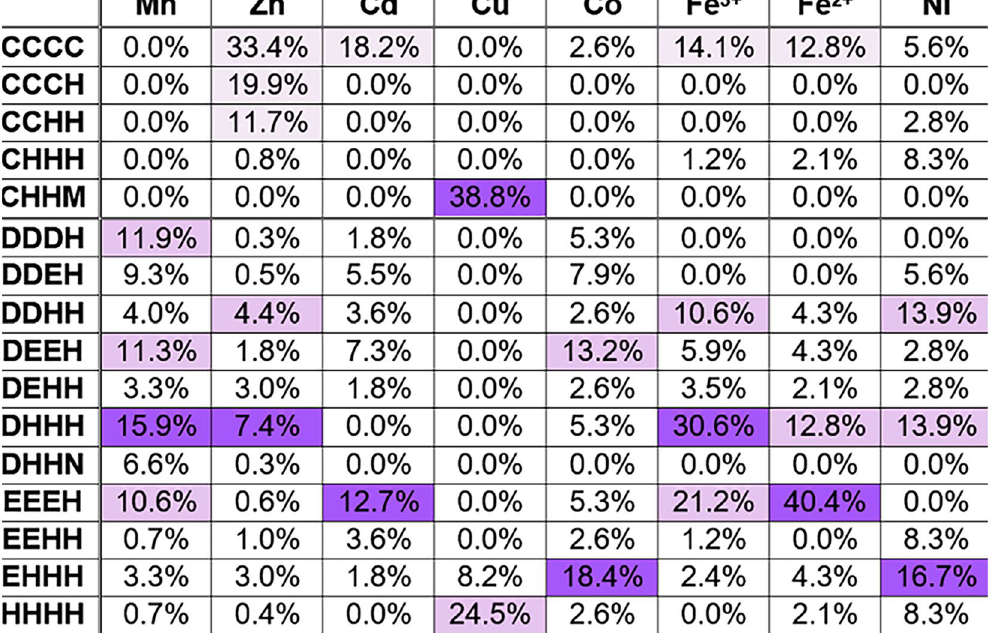
Figure 5. Most abundant quartet distribution of the different metals. For each metal, the quartet percentage is defined as the number of times the metal was bound by the specific quartet divided by the total number of quartets to which the metal was bound. The cysteine-containing quartets (first five lines) are separated from the other quartets due to the tendency of the former to participate in structural sites rather than enzyme active sites. Darker purple colors represent higher binding tendencies. As they are less relevant for enzymes active sites, the high tendencies of quartets containing more than one cysteine (first three lines) are exceptional and are presented in light